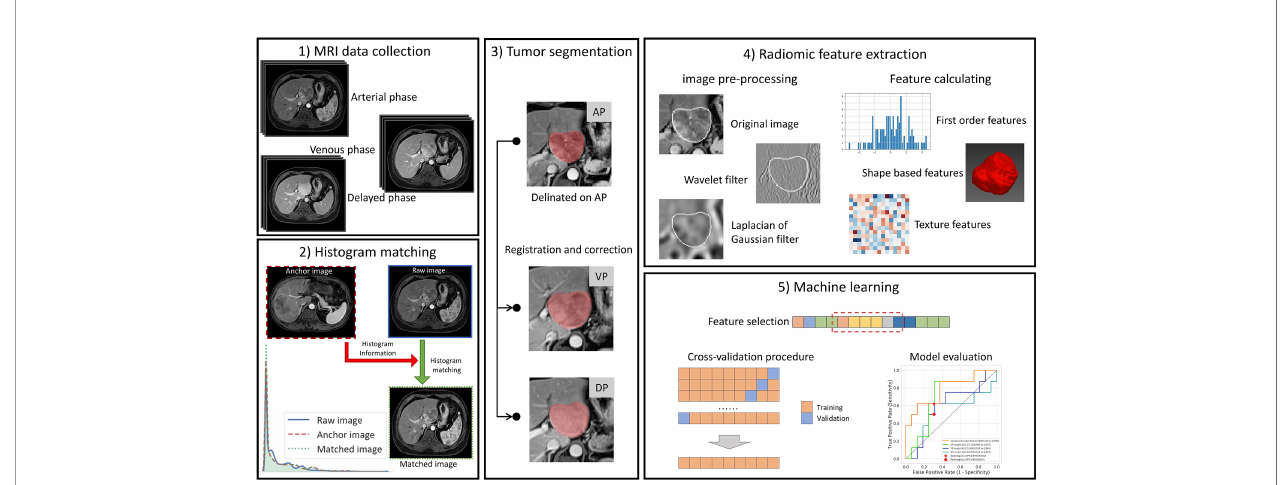
FIGURE 2 | The work fl ow of our study. (1) The collection of CE-MRI data, including the arterial phase (AP), venous phase, and delayed phase images. (2) Histogram matching: The images of each phase were matched to the corresponding phase of the fi rst patient by histogram matching. (3) Tumor segmentation: The delineation was performed on AP and then registered to the other two phases, and the misalignment was manually corrected. (4) Radiomic feature extraction: For each phase, the radiomic features were extracted from the tumor region of the original images and the preprocessed images. (5) Machine learning. The feature selection method was used to select the optimal feature subset, and then the models were trained by the cross-validation procedure and evaluated on the internal and external validation cohort.